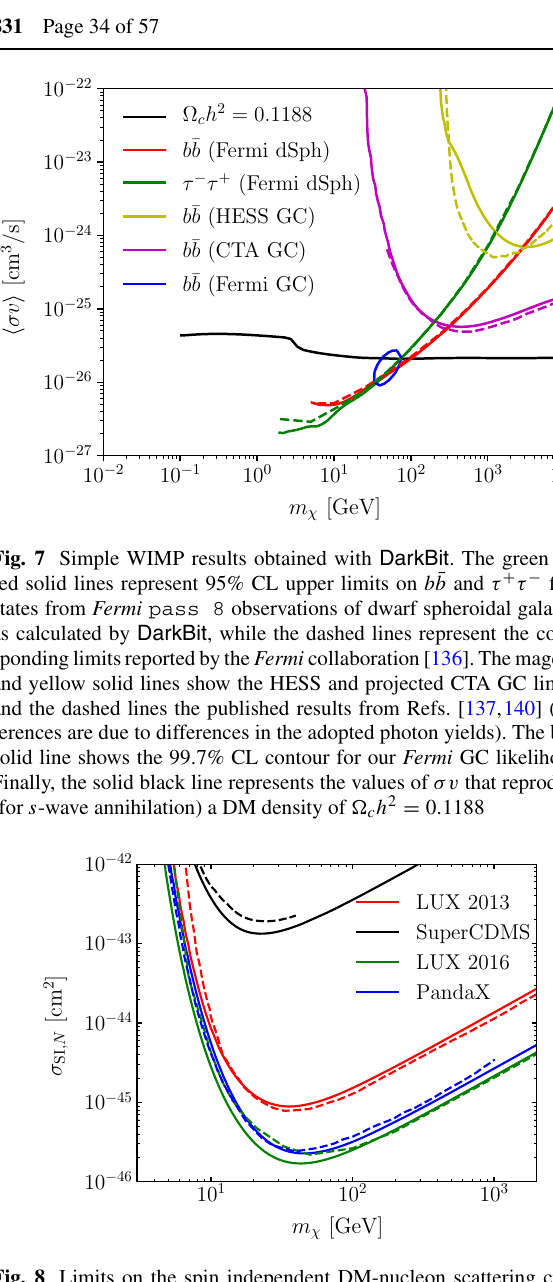
Fig. 8 Limits on the spin independent DM-nucleon scattering cross section from SuperCDMS, LUX, and PandaX at 90% CL. The solid curves are the limit determined using DarkBit and the dashed curves are the official limits from the collaborations [73,75,76,78]